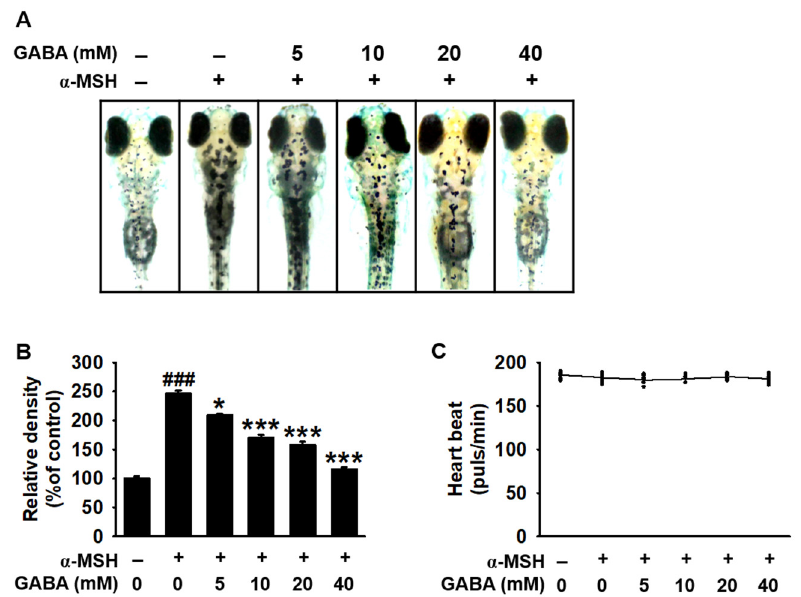
Figure 3. GABA inhibits melanogenesis in zebrafish larvae. Two days post-fertilization (dpf), zebrafish larvae were pretreated with 0.003% PTU for 24 h and then treated at 3 dpf with the indicated concentrations of GABA (0–50 mM) in the presence and absence of 1 µ g/mL α -MSH for an additional 72 h. ( A ) Images of zebrafish larvae were captured using a stereomicroscope (4 × ). ( B ) Melanin densities were quantified using ImageJ software and are expressed as a percentage compared with the untreated larvae. ( C ) The heart rate was assessed to evaluate the cardiotoxicity and is represented as heartbeats/min. The results represent the average of data obtained from three independent experiments and are expressed as the mean ± standard error of the mean (SEM) ( ### p < 0.001 vs. untreated larvae; *** p < 0.001 and * p < 0.05 vs. α -MSH-treated larvae). GABA, gamma-aminobutyric acid; α -MSH, α -melanocyte-stimulating hormone.